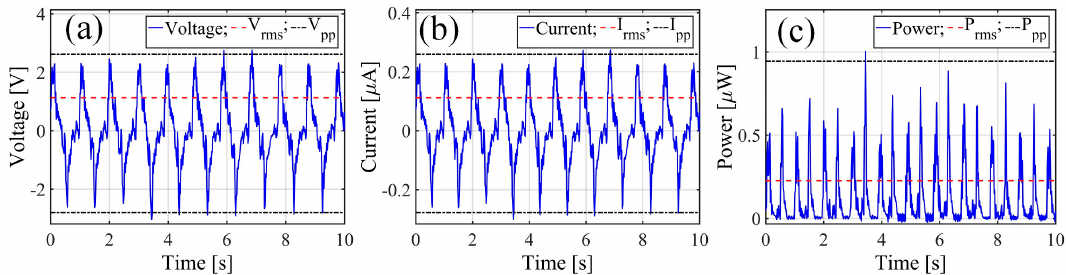
Figure 5. Output responses of the Stretchable TrEG while knee motion ( a ) voltage; ( b ) current and ( c ) corresponding power for RL of 10.1 M Ω